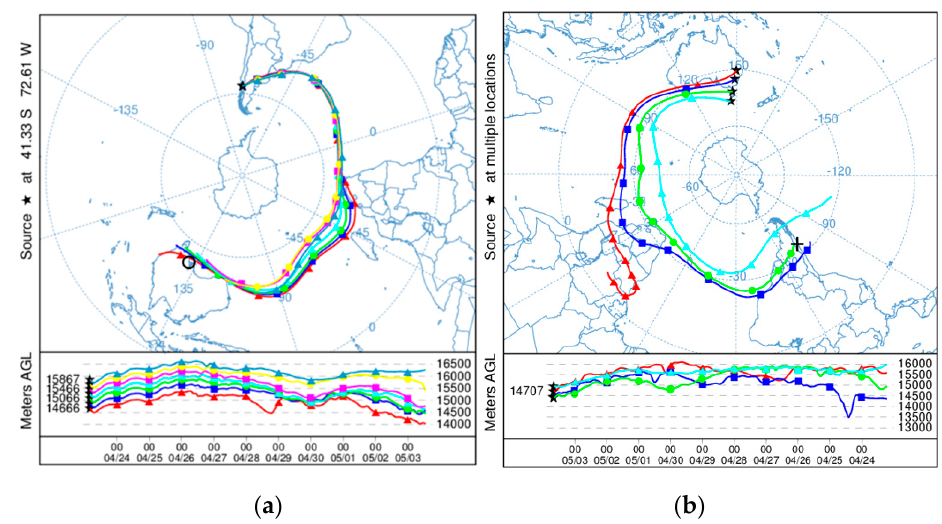
Figure 4. Similar to Figure 3, HYSPLIT trajectory analysis using ERA-Interim 0.75 ◦ reanalysis. ( a ) Forward trajectories started at Calbuco (star) at 23 April 2015 04:00 UT (the time of the second eruption) for starting heights above mean sea level (MSL) of 15.3 km to 16.5 km at 200 m intervals. The duration is 249 h and ends at approximately the time of the Buckland Park lidar measurement on 3 May. The location of Buckland Park is marked by an open circle. ( b ) Backward trajectories started at latitude-longitude pairs (30.39 ◦ S, 144.77 ◦ E), (34.62 ◦ S, 148.64 ◦ E), (40.66 ◦ S, 146.88 ◦ E) and (45.94 ◦ S, 144.99 ◦ E) at heights above MSL of 15.0, 15.0, 14.5 and 15.0 km, respectively (corresponding to geographical locations along the stratospheric aerosol layer in Figure 2b). The duration is 251.5 h and ends at 23 April 04:00 UT. The location of Calbuco is marked by ‘ +